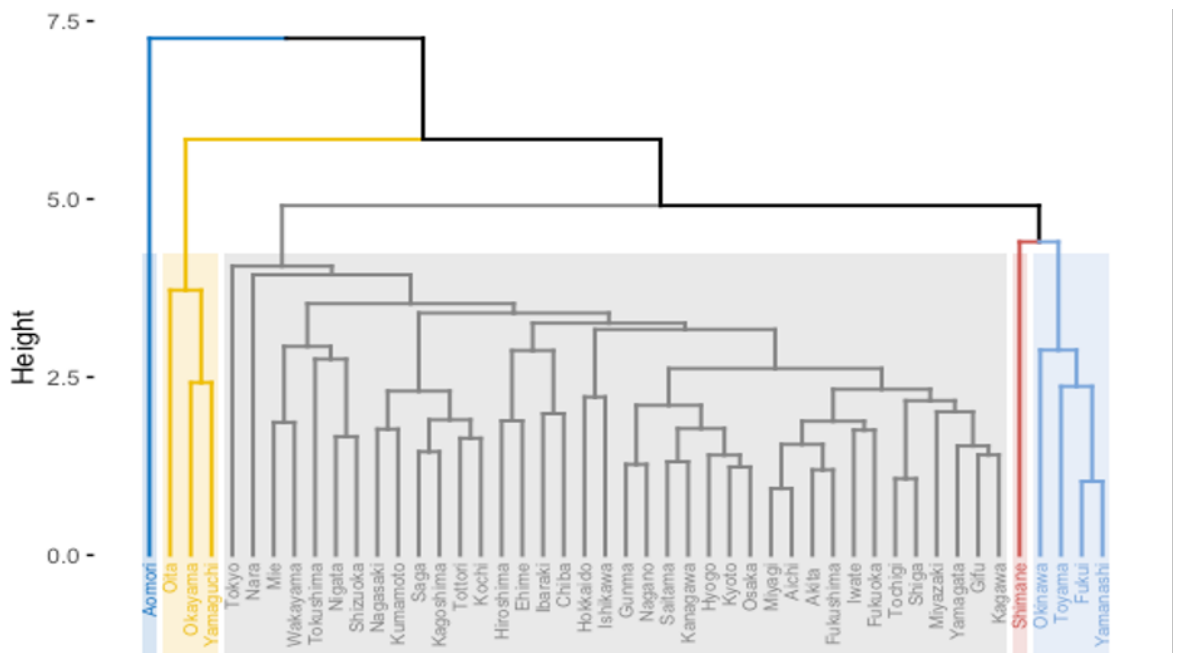
Figure 3. Dendrogram of agglomerative hierarchical clustering results.